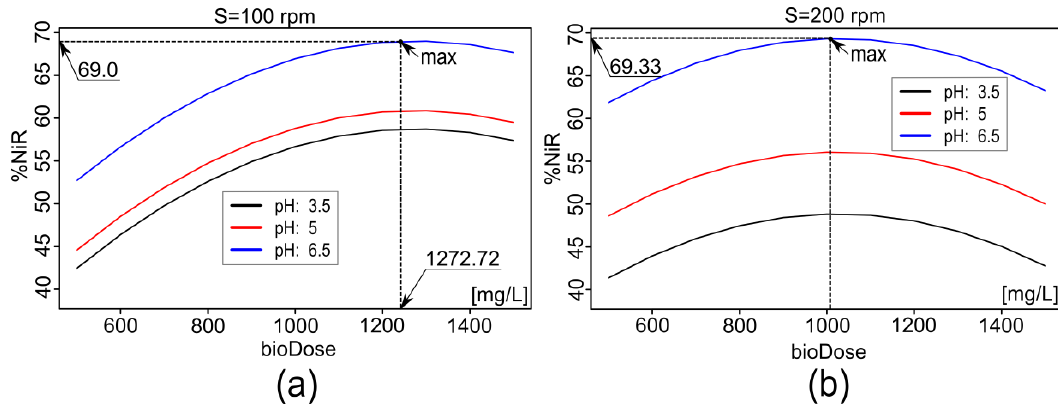
Figure 4. %NiR vs. bioDose for di ff erent values of pH when: ( a ) S = 100 rpm; and, ( b ) S = 200